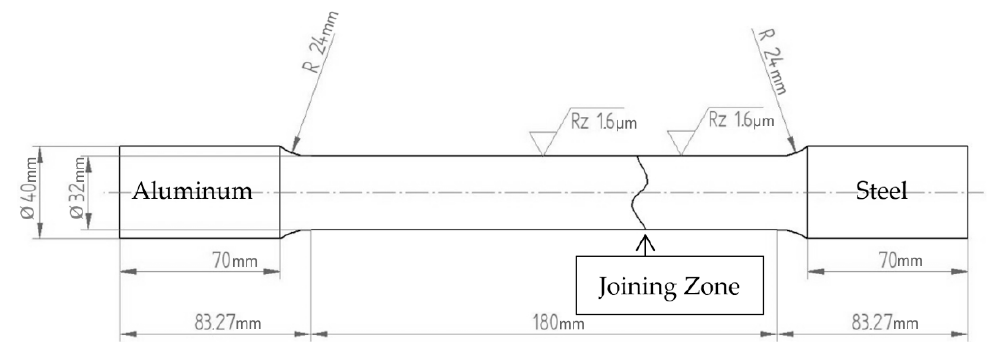
Figure 4. Geometry of tensile samples with highlighted position of the joining zone, according to DIN EN ISO 6892-1 [18], in millimeters.